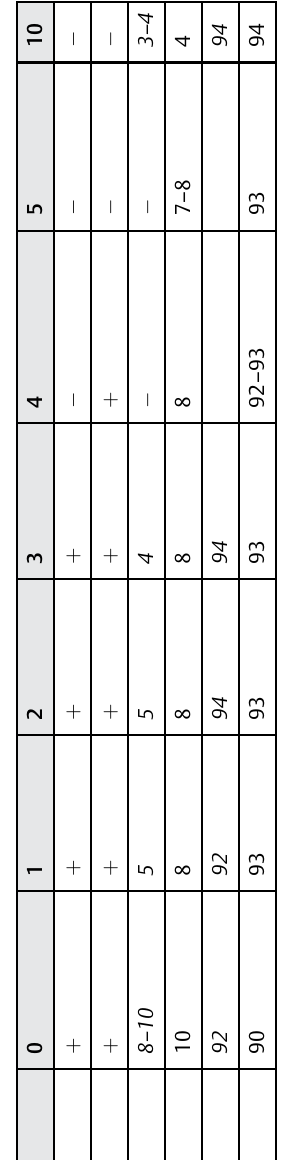
Fig. 1 Views from chest computed tomography of the cases ( A ¼ Case1, and B ¼ Case